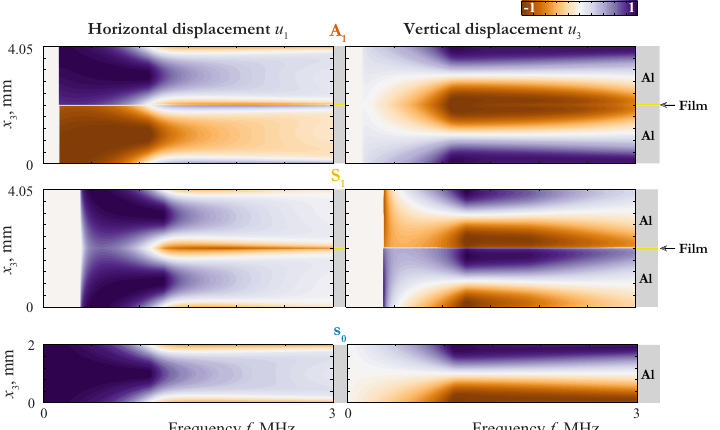
Figure 4. Displacement distribution u k ( x 3 , f ) of LWs A 1 and S 1 propagating in 4.05 mm thickness plate (2 mm aluminium/50 µ m film/2 mm aluminium) and LW s 0 propagating in 2 mm thickness aluminium plate.